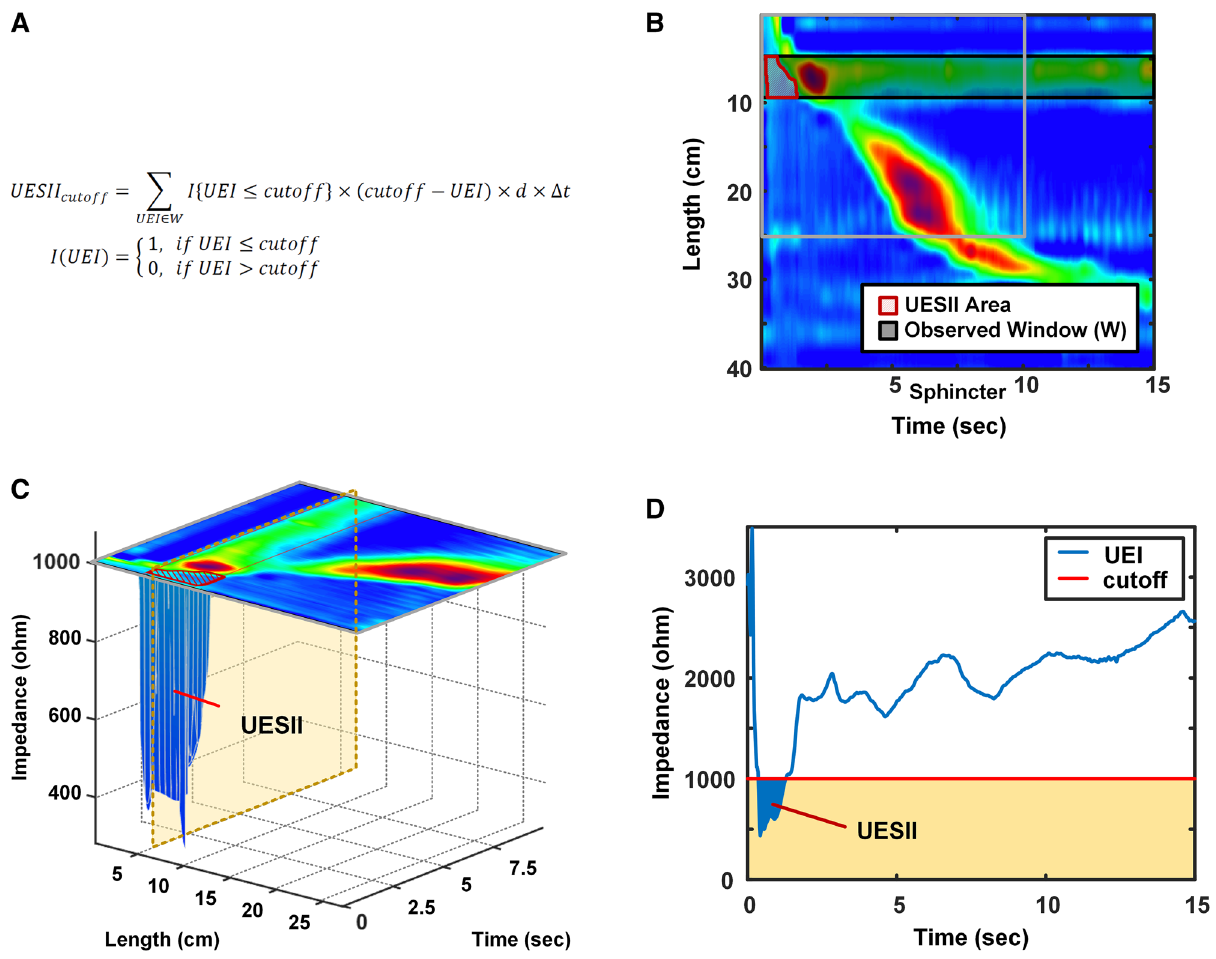
Figure 1. ( A ) In the formula of upper esophageal sphincter impedance integral (UESII), the “ UEI ” means upper esophageal impedance, “ d ” means the distance between two adjacent impedance channels, “ Δt ” is the sampling interval, “ W ” is the observed window, and “ I ” is the indicator function. ( B ) The 2D plot of UESII of the wet swallow. ( C ) The 3D plot of UESII of the wet swallow was demonstrated. ( D ) Calculation of the UESII value at less than 1000